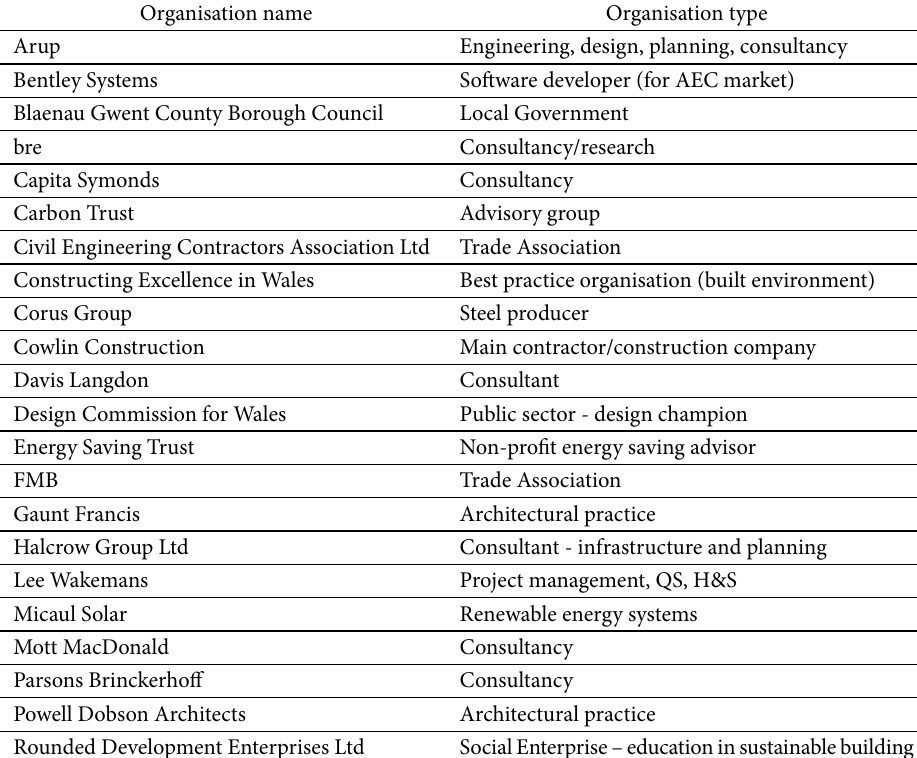
Table 1. Illustration of the Wales participant